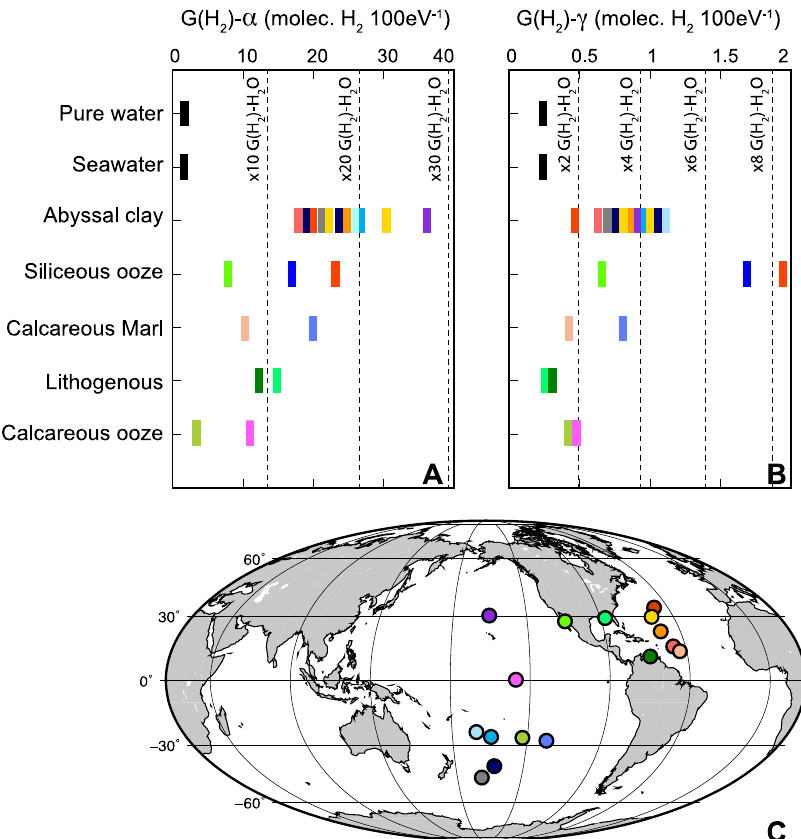
Fig. 1 Radiolytic H 2 catalysis by marine sediment. Experimental H 2 yields for α irradiation ( A ) and γ irradiation ( B ). Reported yields are averages of a minimum of four replicate experiments. Vertical dashed lines represent multiples of production in pure water. Site locations ( C ) color-coded to indicate origins of samples in A and B